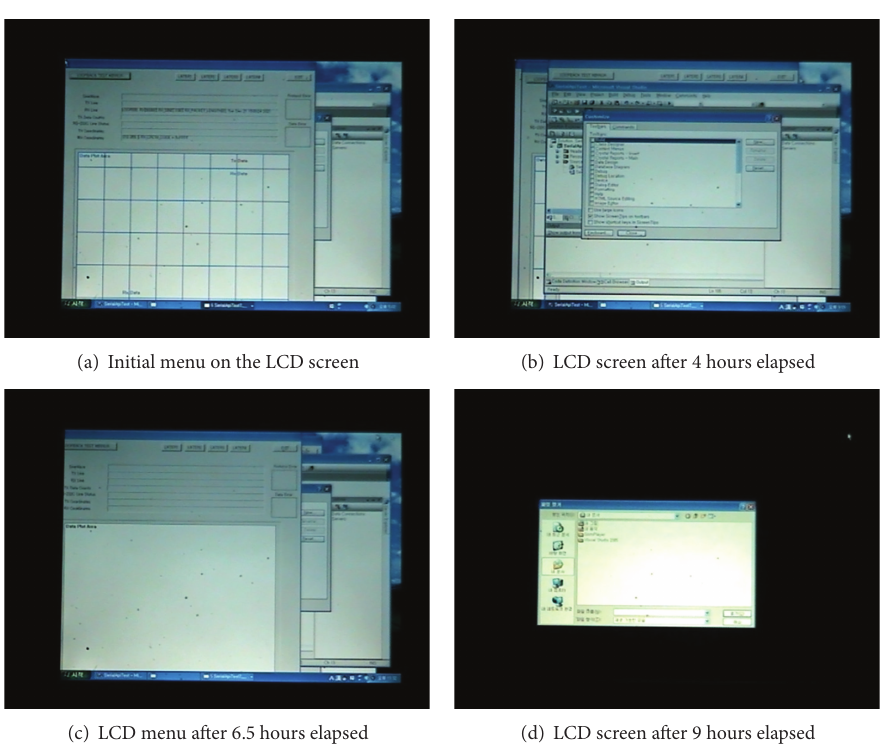
Figure 7: LCD screen changes of the postirradiated notebook PC during the annealing test after gamma ray irradiation